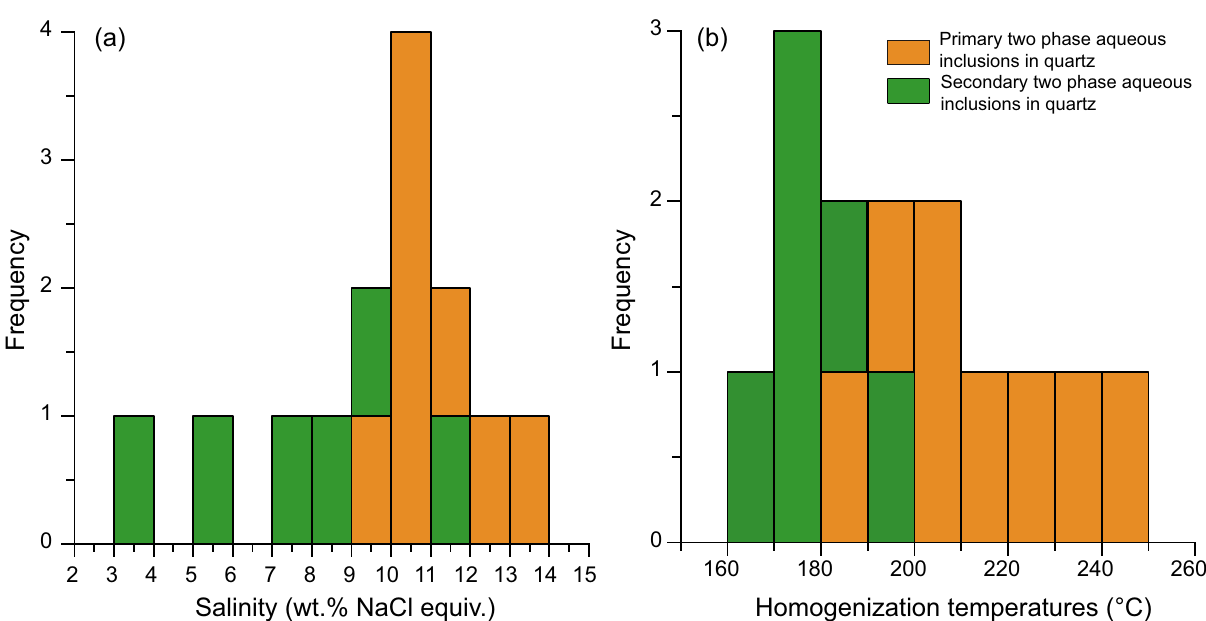
Figure 4. Histograms of salinities ( a ) and homogenization temperatures ( b ) of fluid inclusions in the Au-bearing quartz vein from the Liaotun gold